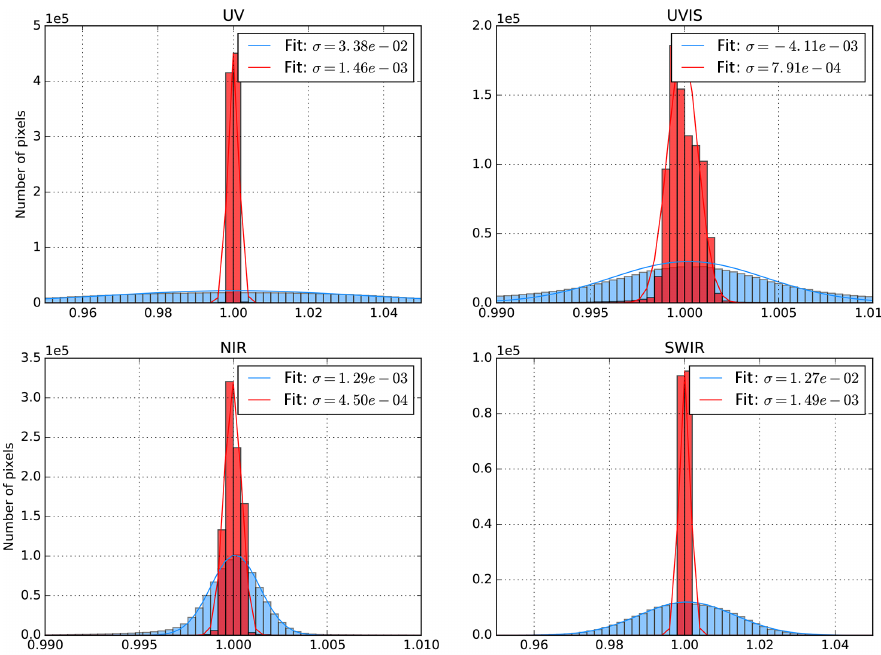
Figure 20. The PRNU for each detector as a function of the detector pixels after double processing. The figure shows the histogram of the PRNU values of all pixels on each detector. The original PRNU distribution is shown in blue and the distribution after double processing in red.